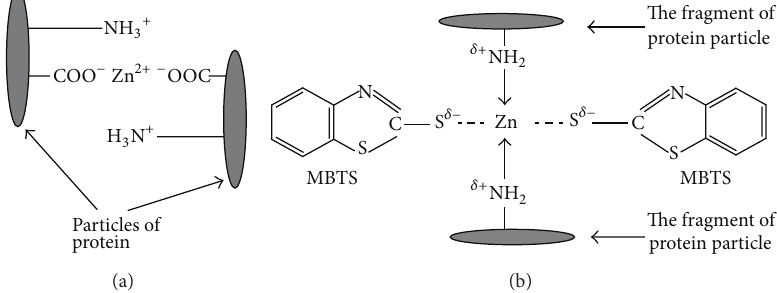
Figure 2: The schematic diagram shows (a) the probable coordination of ions of zinc with amine and protein carboxylic groups, (b) the possible complex connections between the fragment of protein particle (keratin), MBTS (dibenzothiazyl disulfide), and ZnO